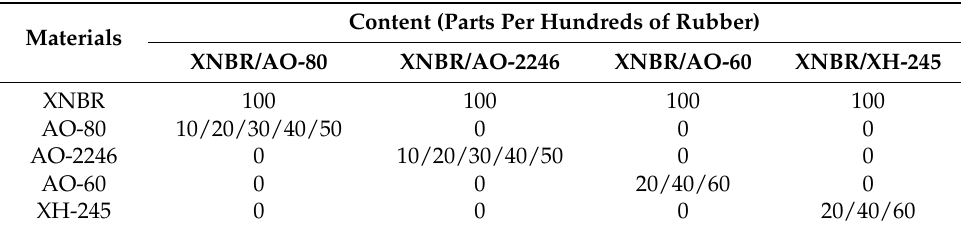
Table 1. Material formulations of rubber